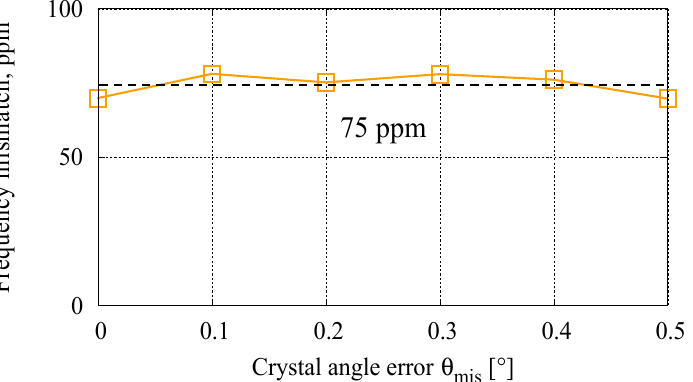
Figure 7. Frequency mismatch between two resonant modes (in the optimized design) under different angle error of crystal Si.